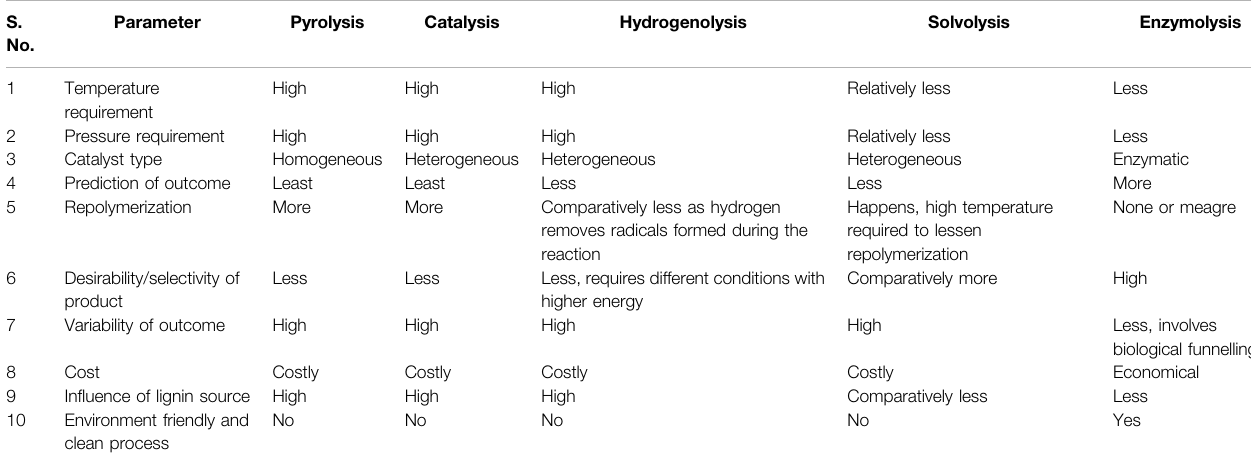
TABLE 1 | Comparative analysis of diverse methods used in lignin deconstruction. S.